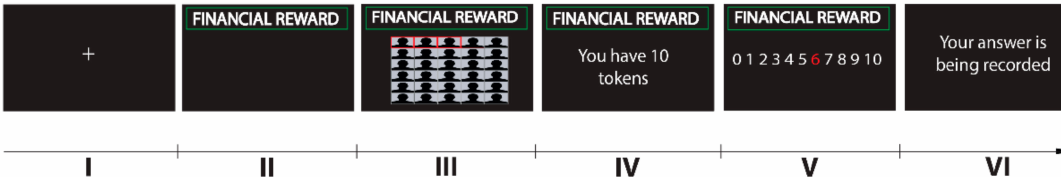
Figure 2. Trial outline. The beginning of each trial was indicated by a fixation cross, followed by a screen revealing the upcoming trial type (screen II). Participants were paired with three randomly selected other people from the participant pool (screen III). Screen IV showed how many tokens participants received, and on screen V, participants were asked to indicate how many tokens they liked to contribute to the group pot. The final screen VI showed that the participant’s choice was being